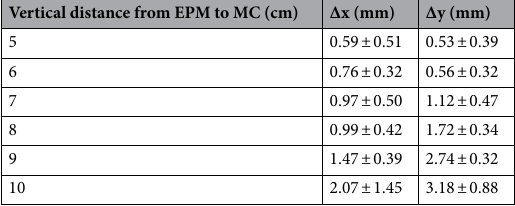
Vertical distance from EPM to MC (cm)